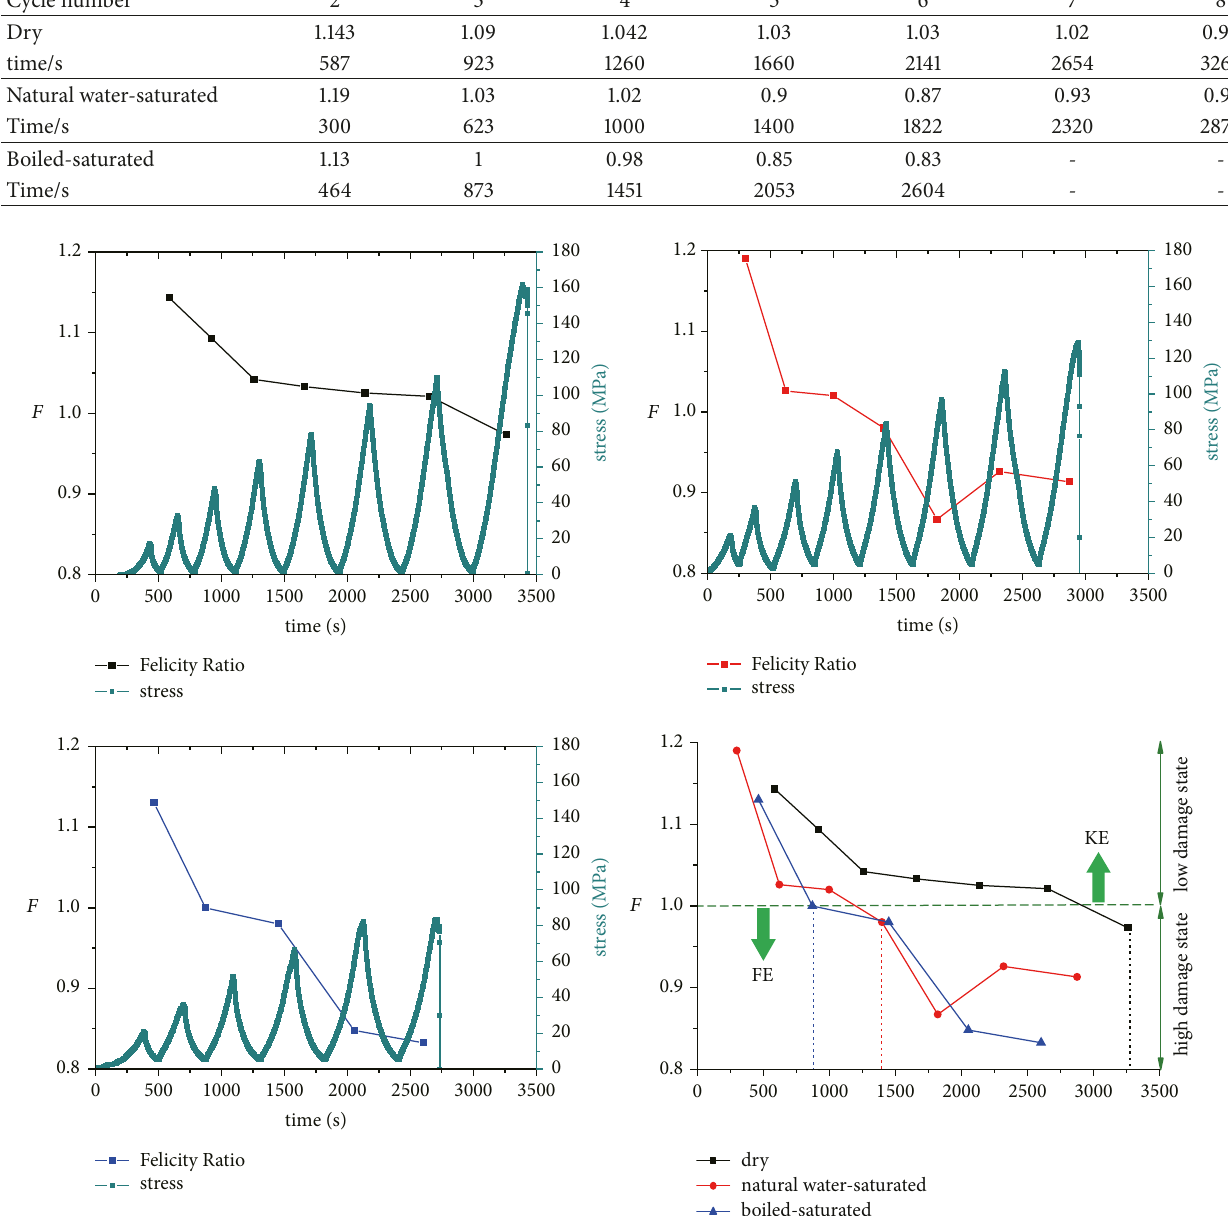
Figure 13: Felicity Ratio and stress of the different water content specimens in function with time. KE refers to the Kaiser Effect; FE refers to Felicity